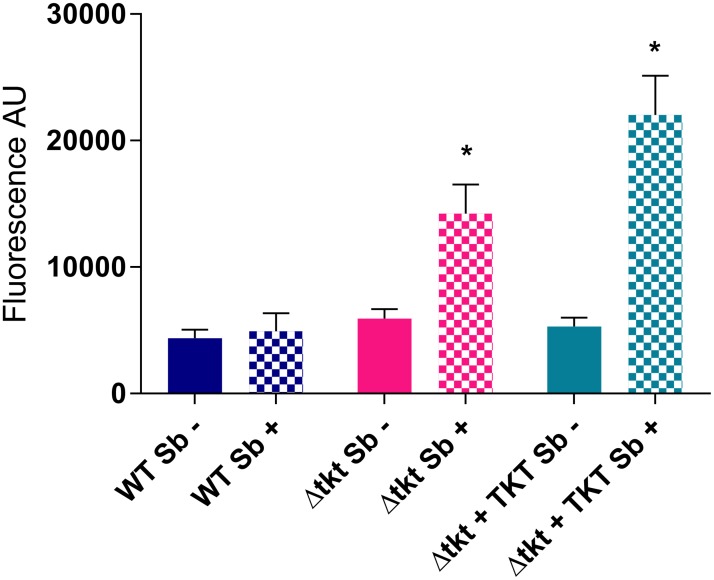
Measurement of reactive oxygen species by DCFDA.Reactive oxygen species inside cells were assessed directly by measuring DCFDA fluorescence. Whereas in untreated cells, ROS levels were slightly but significantly higher in Δtkt than WT, the difference was much more prominent after 8 h treatment with 200 μM potassium antimonyl tartrate, n = 6, * p < 0.0001.